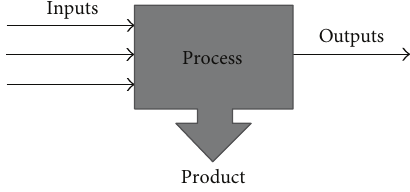
Figure 4: Schematic of the modeling life cycle